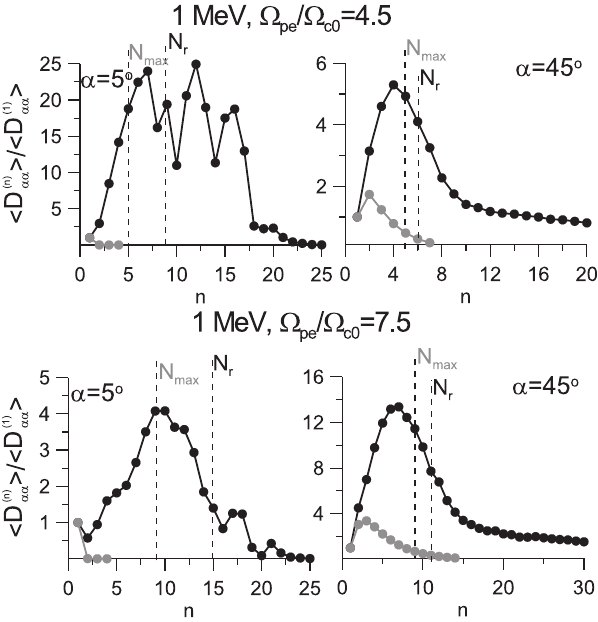
Fig. 12. Individual bounce-averaged diffusion coefficient h D n i as a function of n . The black solid and black dashed vertical lines show the values of N s and N r , respectively. Here E = 1MeV and α 0 = Max 5 ◦ , 45 ◦